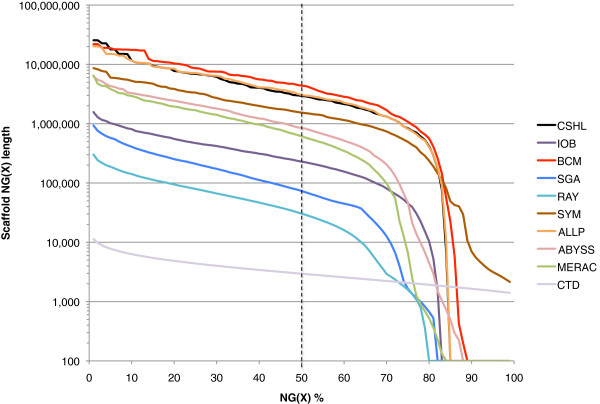
NG graph showing an overview of fish assembly scaffold lengths. The NG scaffold length (see text) is calculated at integer thresholds (1% to 100%) and the scaffold length (in bp) for that particular threshold is shown on the y-axis. The dotted vertical line indicates the NG50 scaffold length: if all scaffold lengths are summed from longest to the shortest, this is the length at which the sum length accounts for 50% of the estimated genome size. Y-axis is plotted on a log scale. Fish estimated genome size = ~1.6 Gbp.